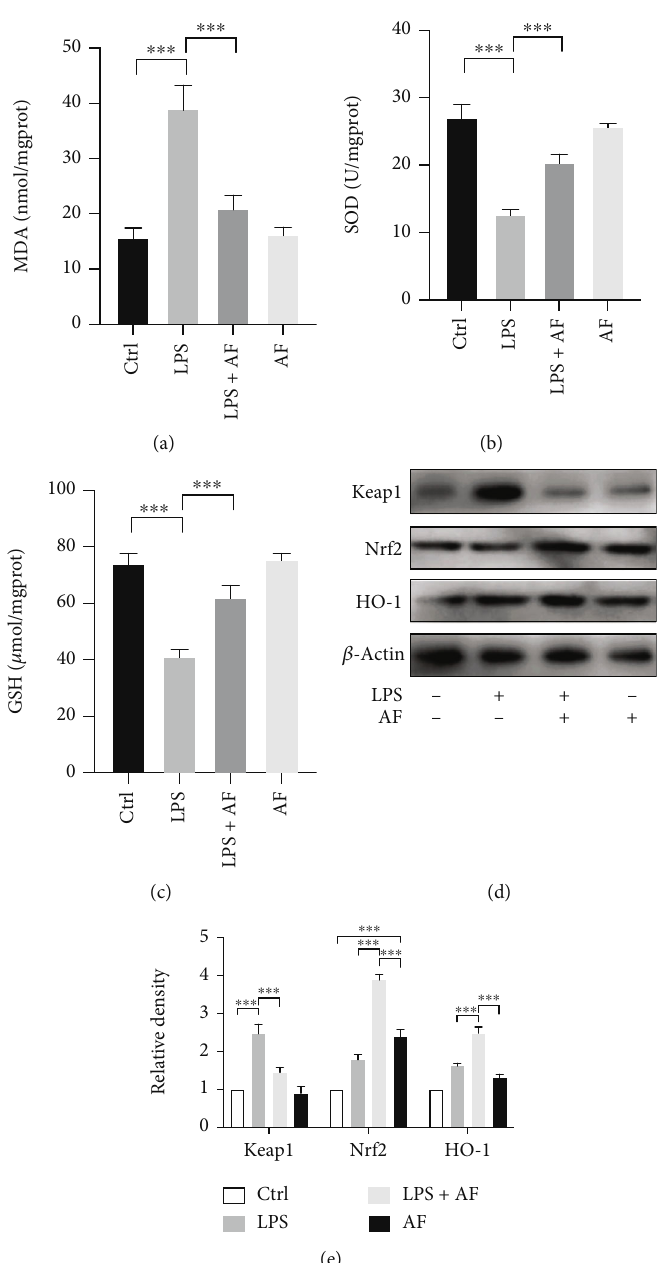
Figure 5: E ff ects of amento fl avone on the expression of Nrf2/HO-1 levels in LPS-treated BV2 microglial cells. (a – c) Semiquantitative analysis of the relative levels of MDA, GSH, and SOD. (d) Representative immunoblots of Keap1, Nrf2, and HO-1 proteins in BV2 microglial cells. (e) BV2 microglial cells were treated with amento fl avone (10 μ Μ ) or 0.5% DMSO for 1h, followed by treatment with LPS (1 μ g/ml) or PBS for 6 h. Semiquantitative analysis of the relative levels of Keap1, Nrf2, and HO-1 by densitometric analysis. Error bars represent mean ± s : d . ∗∗∗ represent P < 0 : 001 , respectively. All experiments were performed in triplicate. LPS: lipopolysaccharide; AF: amento fl